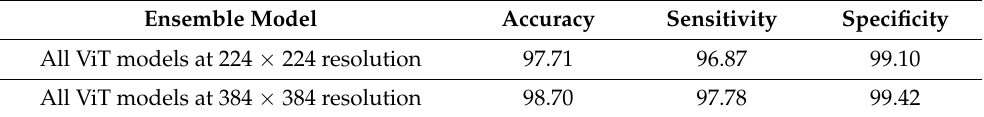
Table 4. Test accuracy, sensitivity, and specificity values are given in percentages for ensemble classification at (a) resolution of 224 × 224 and (b) resolution of 384 × 384. ViT: vision